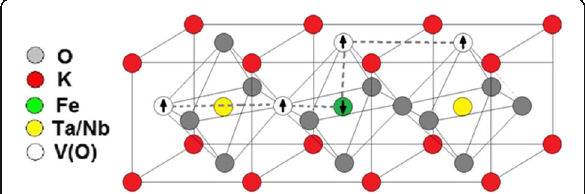
Fig. 6 Model of long-range magnetic order between electrons trapped in oxygen vacancies in the non-stoichiometric KTaO 3 /KNbO 3